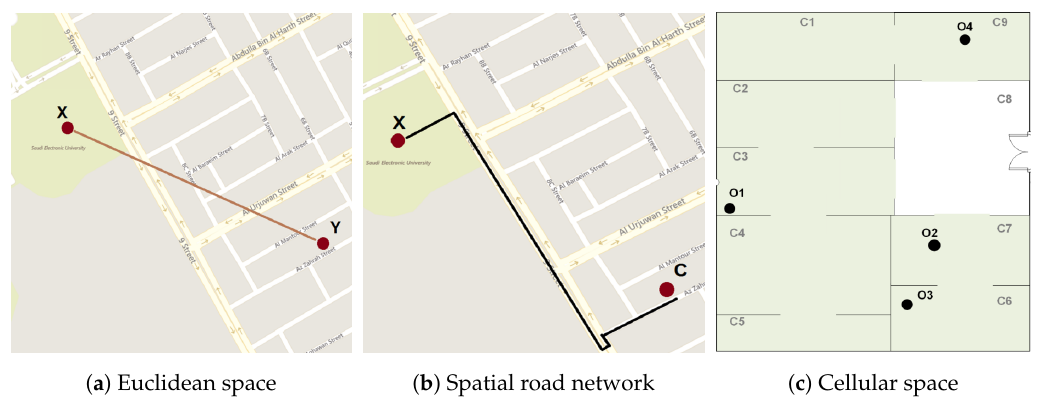
Figure 2. kNN and range queries.